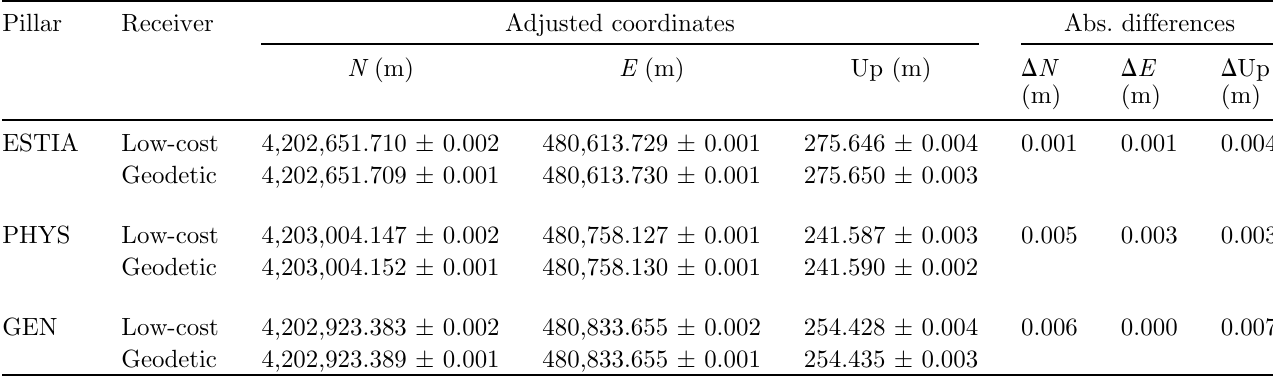
Table 8b. Adjusted network coordinates in planar projection of EGSA87 (minimally constrained solution). Pillar